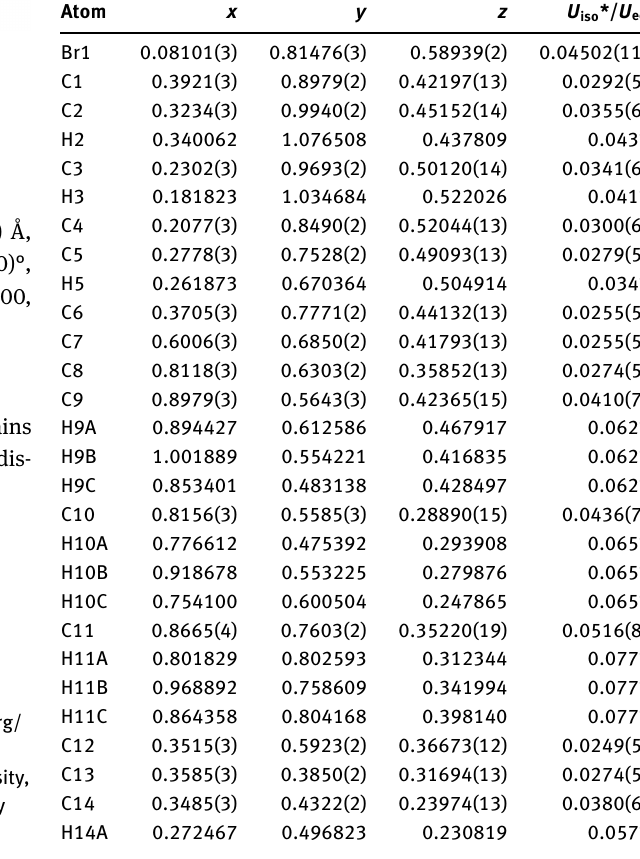
Table 2: Fractional atomic coordinates and isotropic or equivalent isotropic displacement parameters (Å 2